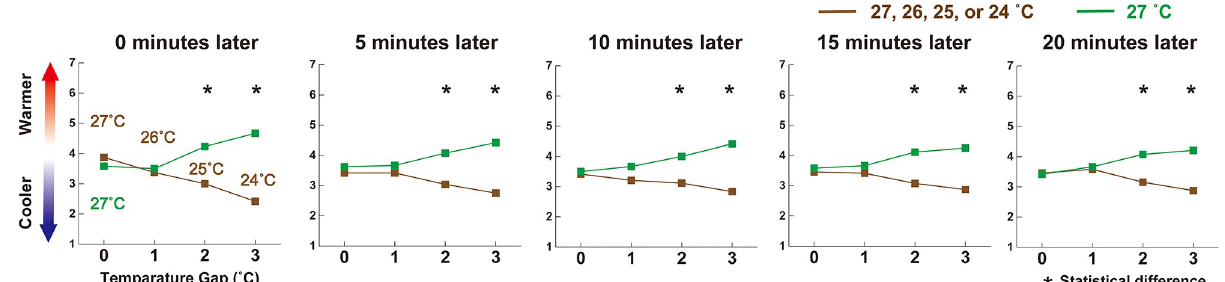
Fig 3. Results of mean subjective evaluations for perceived temperature in the same illuminated rooms at 0, 5, 10, 15, and 20 minutes. Participants noticed a 2 ˚C gap from the moment when they entered the room.